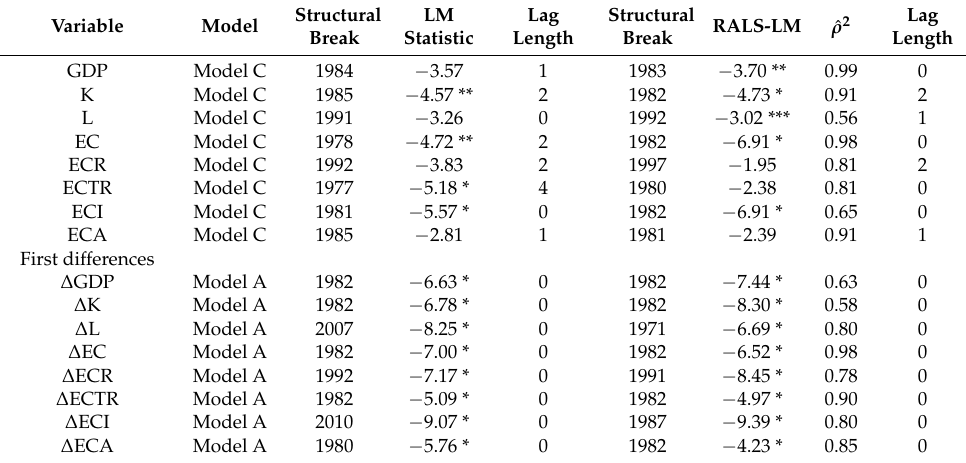
Table 2. LM and RALS-LM unit root tests with one structural